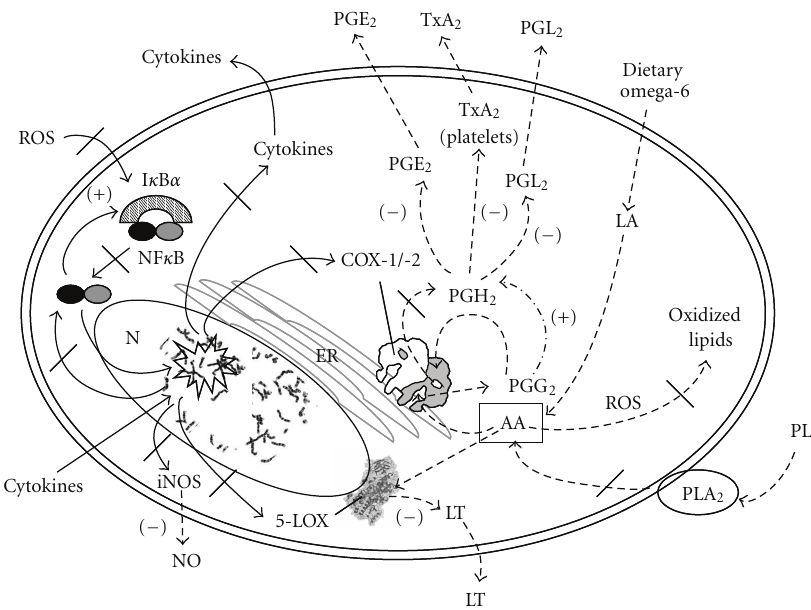
Figure 6: Flavocoxid’s putative mechanism of action inhibiting nuclear (N) ROS activation (black slash) of NF κ B which induces gene expression (star burst) of cox-2 , 5-lox , cytokines, and inos (black slash) through a strong antioxidant stimulatory activity. Dietary omega-6 fatty acids are converted to linoleic acid (LA) (dotted line) and then to AA which are processed through the COX and 5-LOX enzymes. Flavocoxid works on the protein level to limit the production of AA from phospholipids (PL) by inhibiting PLA 2 . It also has been shown to modulate ( − ) PGE 2 , PGI 2 , and TxA 2 generation (dotted line) via an anti-PO activity of endoplasmic reticulum (ER)-anchored COX-1 and COX-2 as well as inhibition of nucleus (N)-associated 5-LOX to decreased LTB 4 production ( − ). PGH 2 may be produced (+) from PGG 2 through and alternate peroxidase activity (dash and dotted line). Flavocoxid has also been shown to restore I κ B α regulation of NF κ B (+). [62]. Flavocoxid’s strong antioxidant capacity also a ff ects inducible inflammatory gene and protein